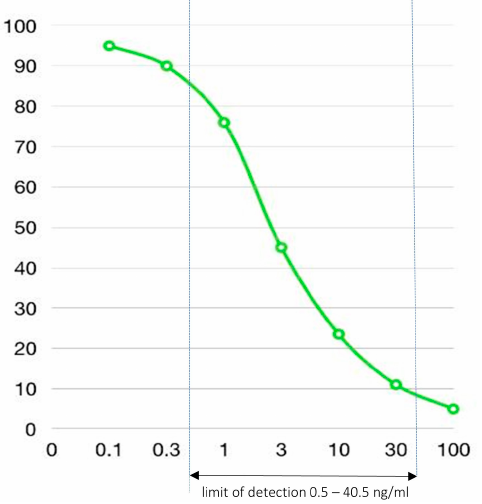
Figure 1. Ceftriaxone standard curve from ELISA kit. x -axis = concentration (ng/mL); y -axis = optical density absorbance spectrophotometry (%).